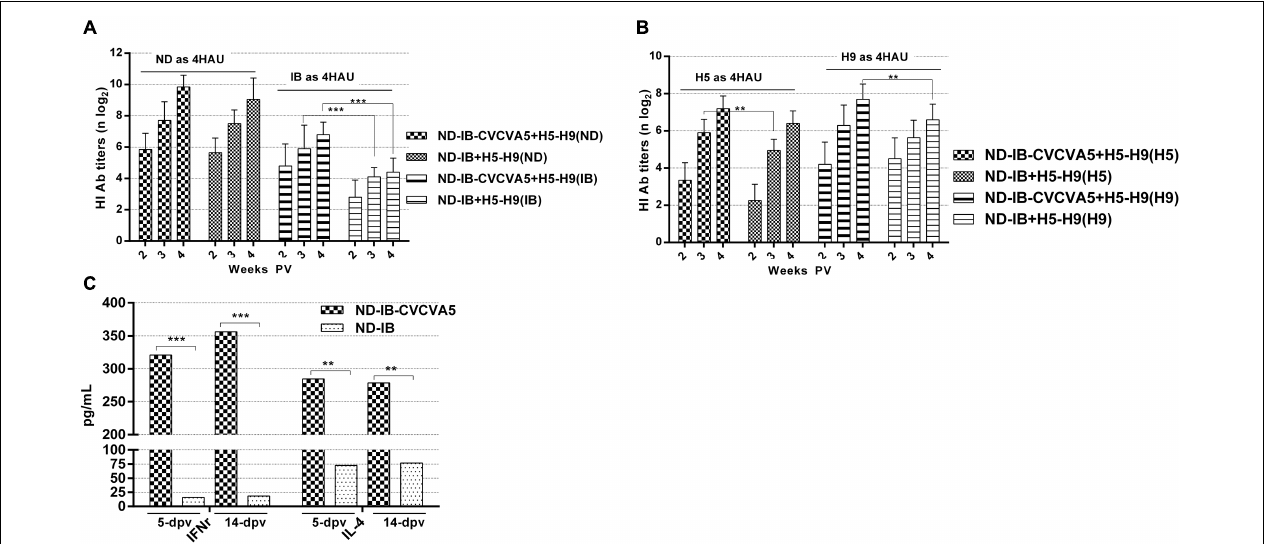
FIGURE 5 | Antibody titers against virus antigen and cytokine levels in program of immunization. The HI titers of serum antibodies at 2-, 3- and 4-week post vaccination of H5-H9 vaccine were measured with four units of hemmaglutinin antigens of ND and IB (A) , H5 and H9 (B) . The cytokine levels of IFN γ and IL-4 in serum were tested at 5- and 14-day post vaccination of ND-IB with or without CVCVA5 (C) . ∗∗ P < 0.01, ∗∗∗ P <